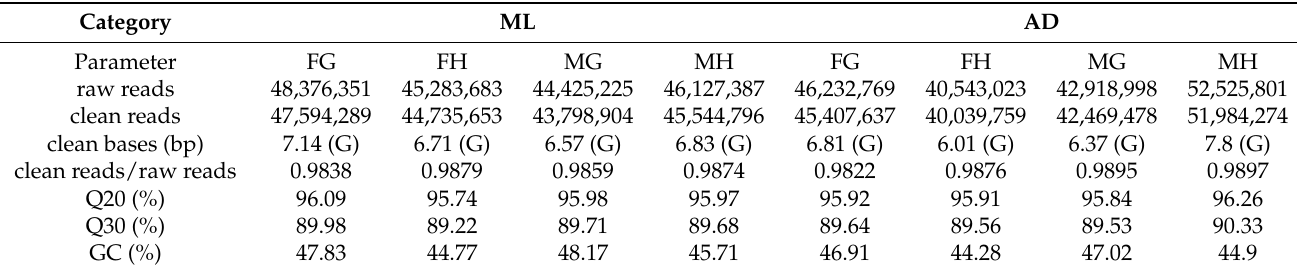
Table 1. Basic information of